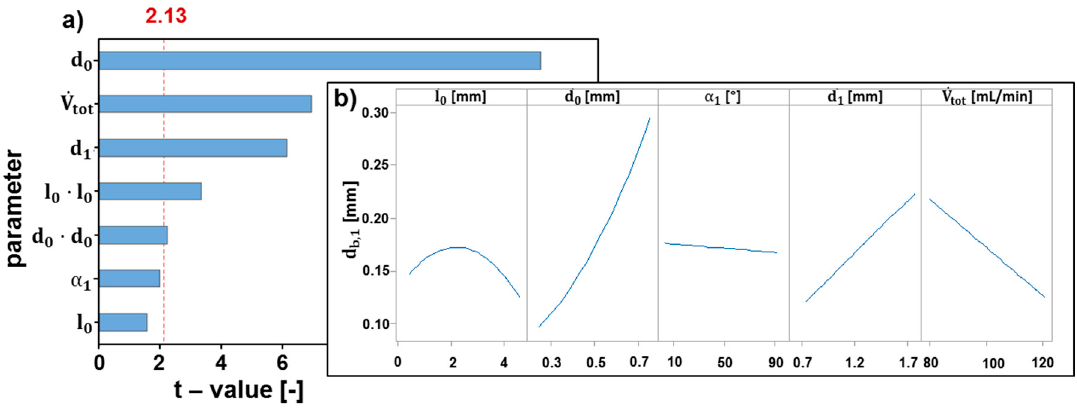
Figure 18. Final Pareto chart of effects ( a ) for mean daughter bubble size after exclusion of non-significant parameters and corresponding main effect diagram ( b ).